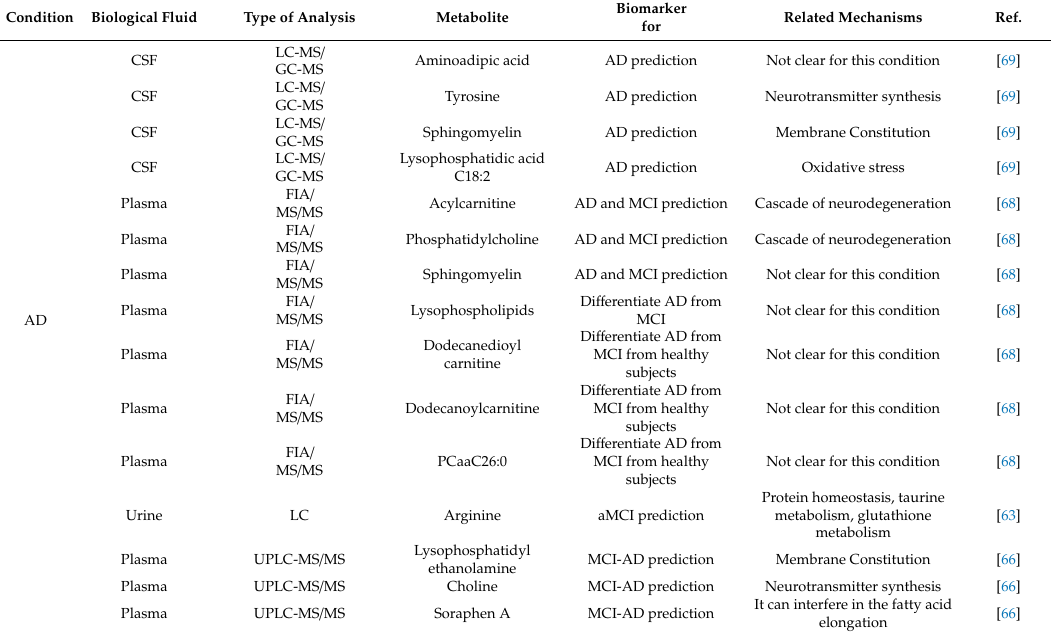
Table 1. Metabolites discovered for each of the main neurological diseases: Alzheimer’s disease (AD), amyotrophic lateral sclerosis (ALS), Epilepsy, multiple sclerosis (MuS), Parkinson’s disease (PD), Stroke. Condition